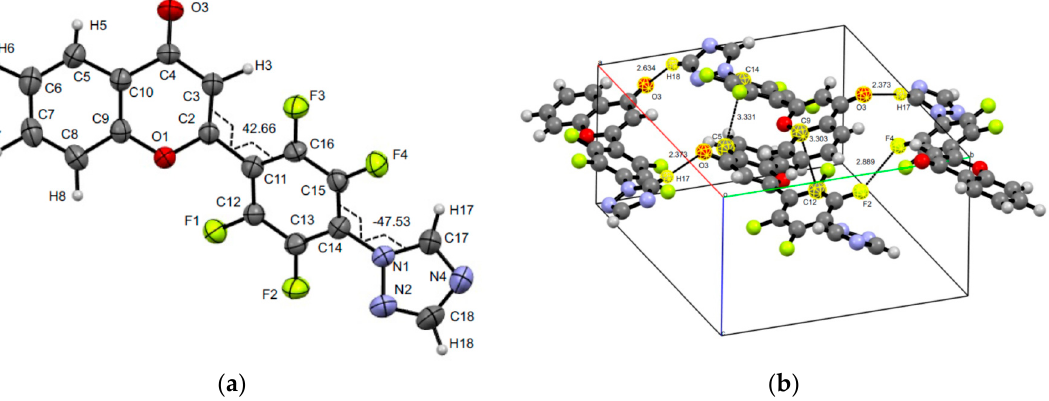
Figure 2. Molecular structure and selected torsions ( a ), and unit cell ( b ) of compound 4 with atoms represented as thermal ellipsoids of thermal vibrations with a 50% probability.